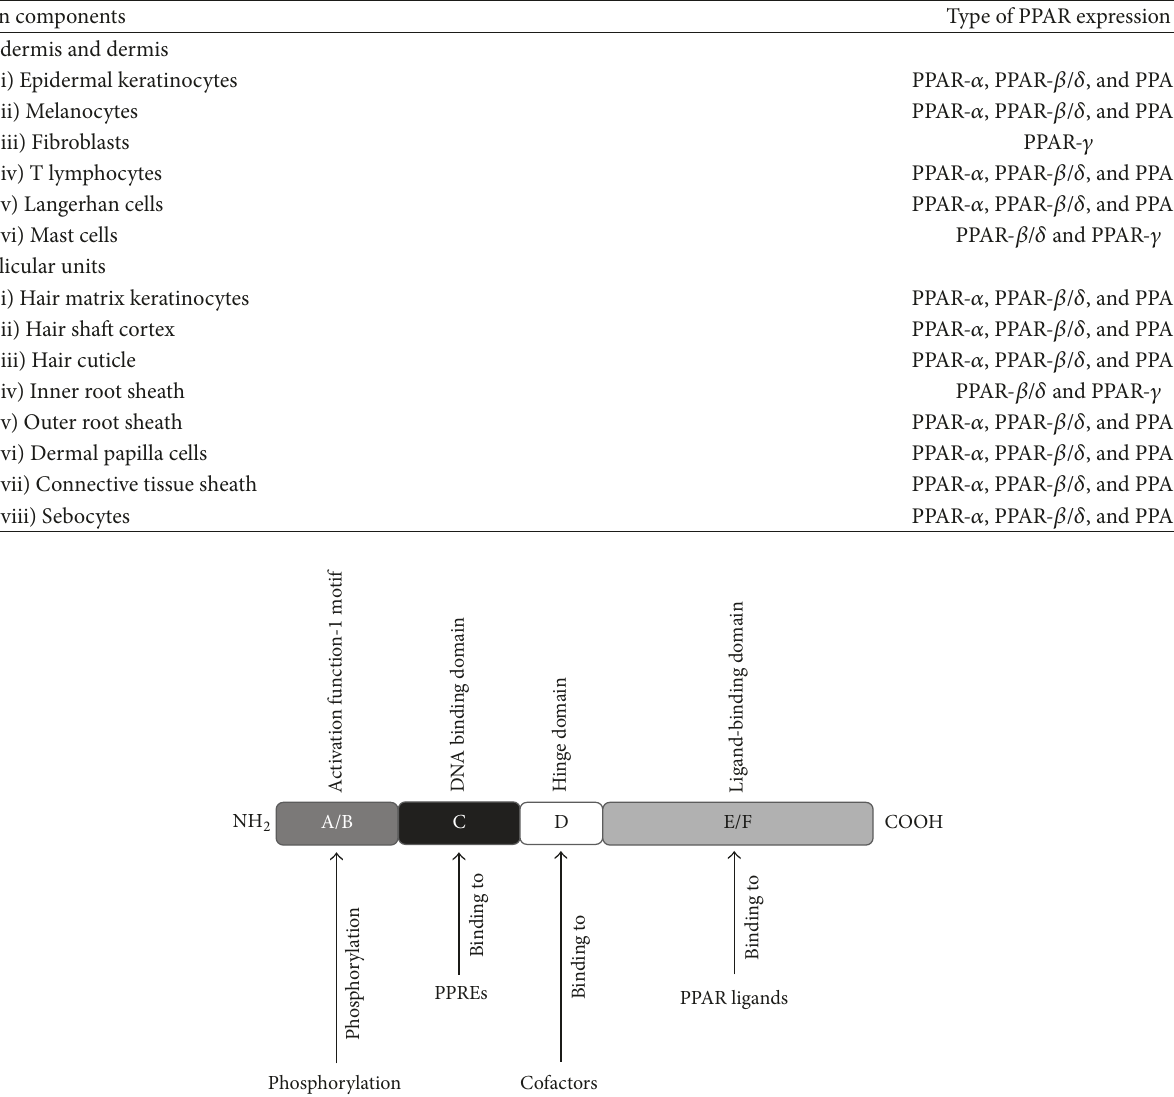
Table 2: Peroxisome proliferator-activated receptors (PPARs) in human skin.